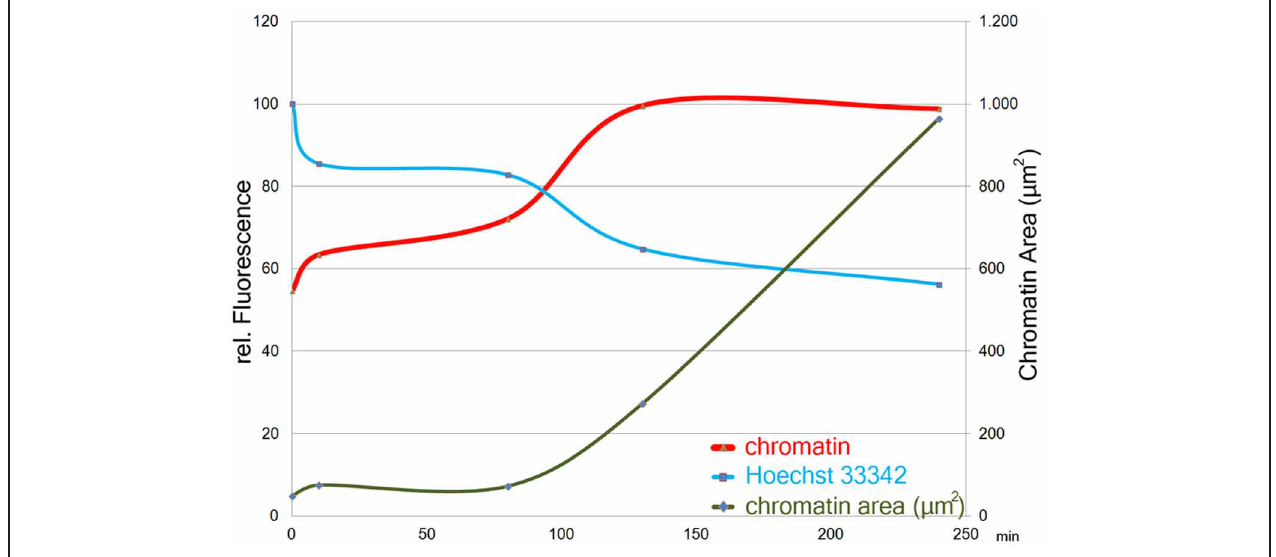
FIGURE 2 | Size (right y-axis) and staining intensities (left y-axis) of automatically segmented objects in images of chromatin- and Hoechst33342- stained cells from a time course of PMA induced